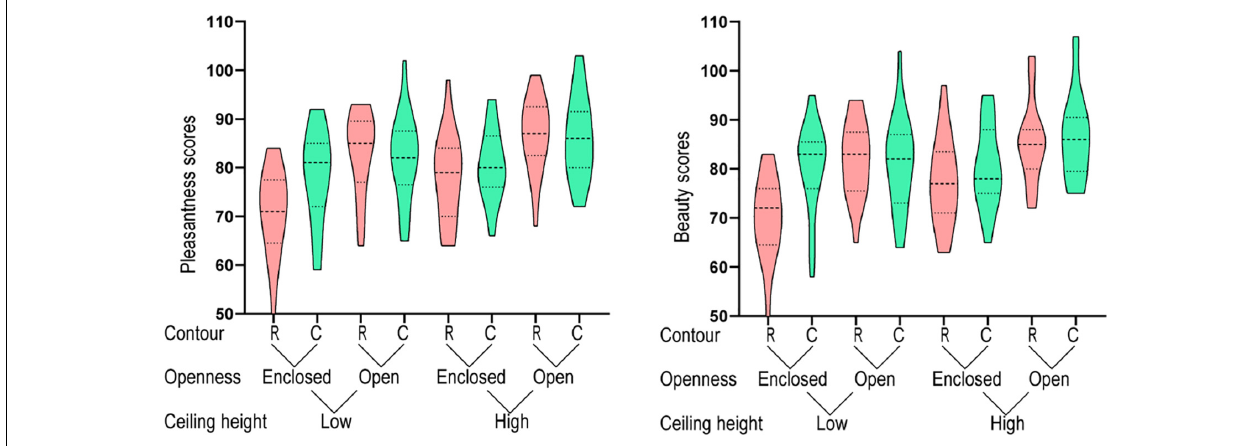
FIGURE 3 | Results for the color-image condition.